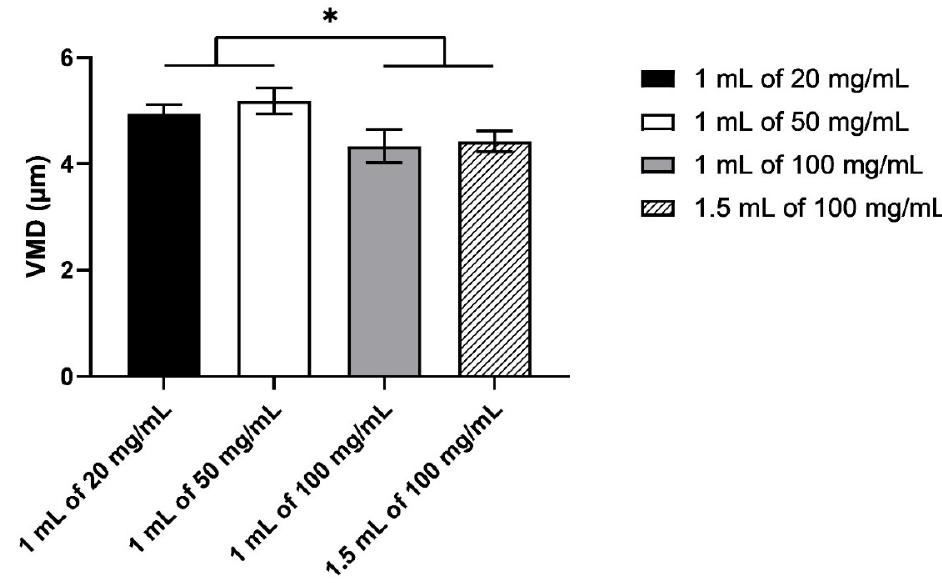
Figure 4. The volumetric median diameter of the droplets measured by laser diffraction. Data presented as mean ± standard deviation ( n = 9). Statistical difference indicated by * ( p < 0.05).